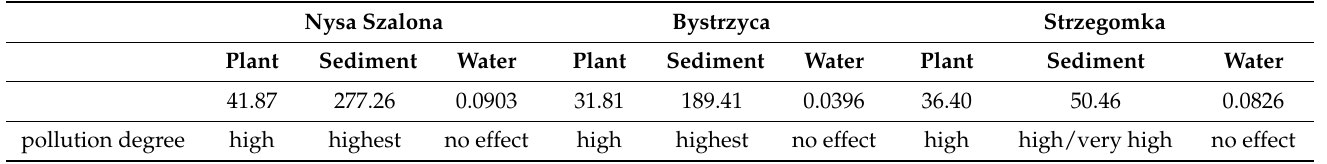
Table 11. Metal pollution index (MPI) of aquatic plants, bottom sediments and water.